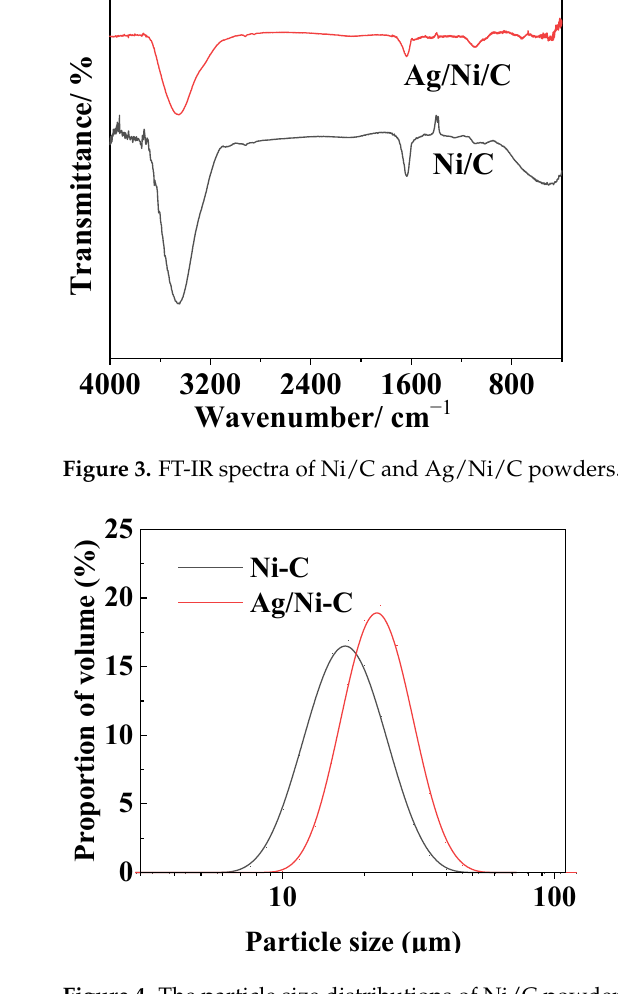
Figure 4. The particle size distributions of Ni/C powder and Ag/Ni/C powders. Table 1. Particle size distributions of the samples.